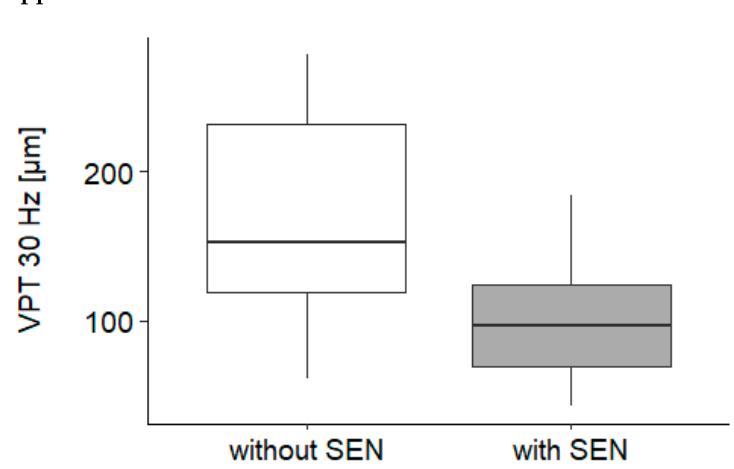
Figure A1. Boxplots showing vibration perception thresholds (VPT) at 30 Hz with and without subliminal electrical noise stimulation (SEN) for most severely affected patients (NDS ≥ 6, n = 6).